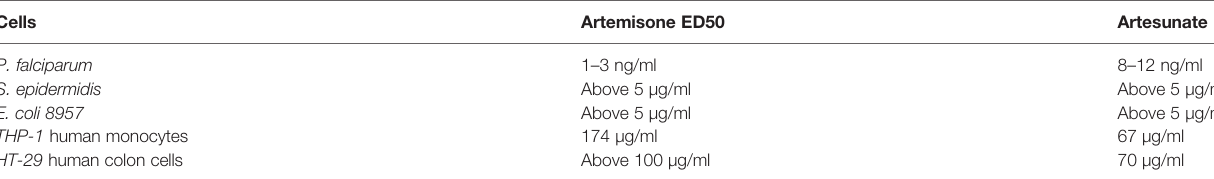
TABLE 1 | Speci fi c and non-speci fi c in vitro effects of artemisone.